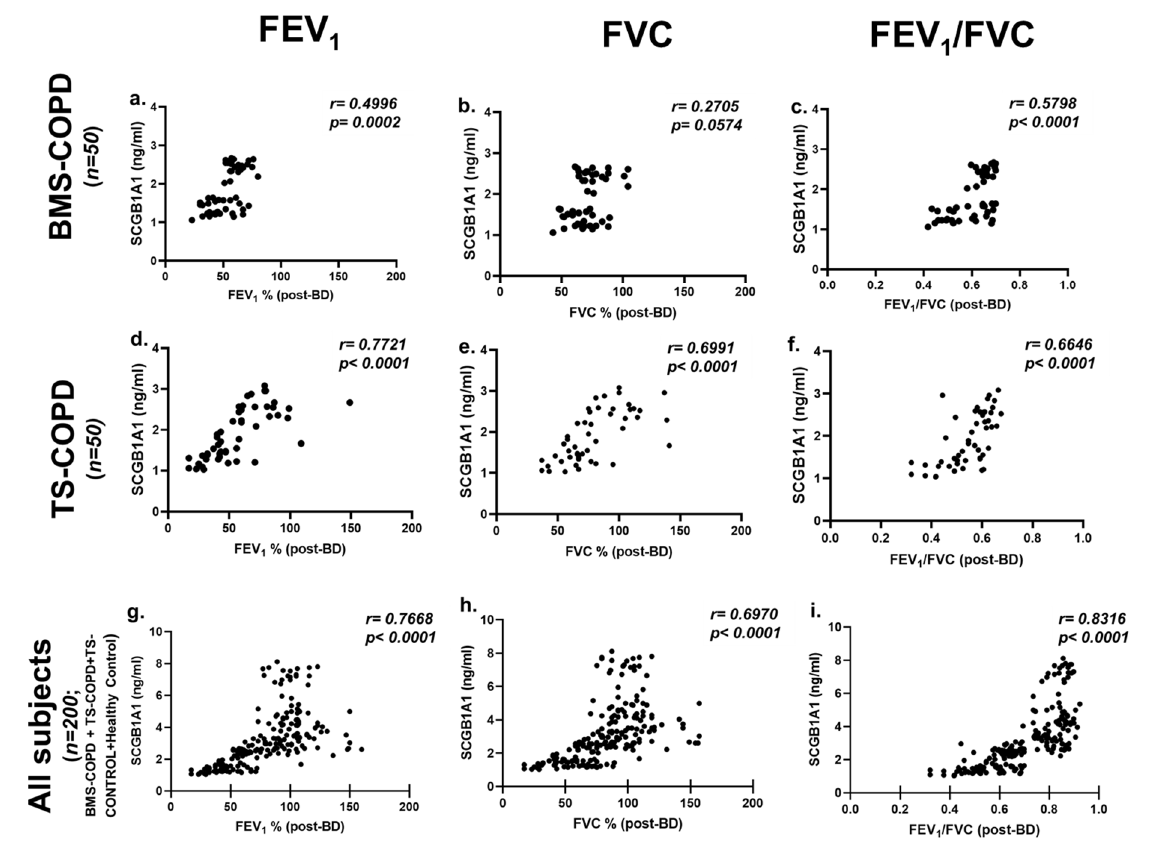
Figure 4. Correlation of serum concentrations of secretoglobin family 1A member 1 (SCGB1A1) with post bronchodilator (post-BD) test of forced expiratory volume in one second (FEV 1 % predicted), forced vital capacity (FVC % predicted), and FEV 1 /FVC among biomass smoke induced chronic obstructive pulmonary disease (BMS-COPD; n = 50; 39 female, 11 male; ( a – c ), tobacco smoke induced COPD (TS-COPD; n = 50, all male, ( d – f ) and all study subjects ( n = 200; 50 TS-COPD, 50 BMS-COPD subjects, 50 TS-CONTROL, and 50 healthy control subjects) ( g – i ). Two tailed non-parametric Spearman’s rank test was used to analyze the correlation. p < 0.05 was considered as statistically significant.